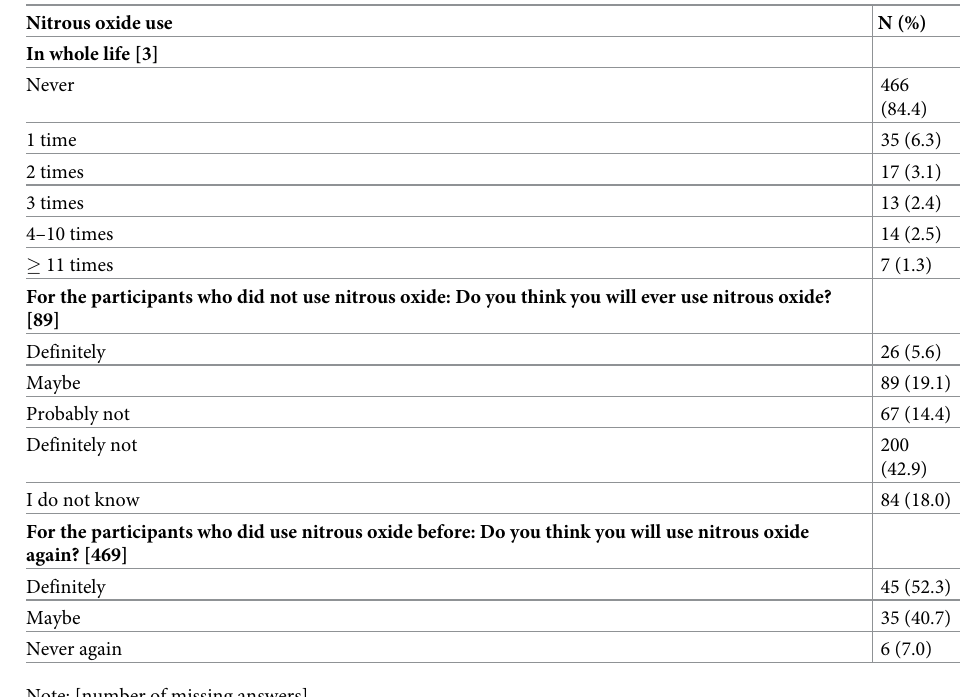
Table 2. Recreational nitrous oxide use in the total population (N =